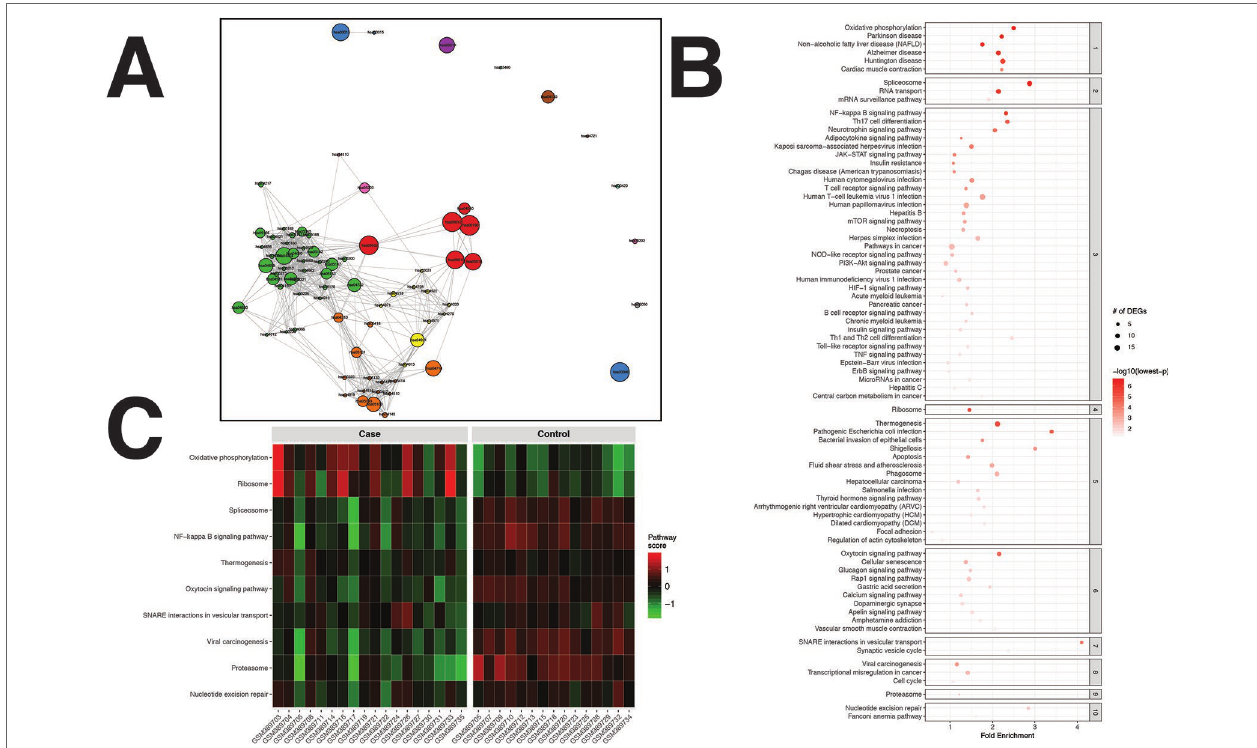
FIGURE 2 | pathfindR enrichment and clustering results on the rheumatoid arthritis (RA) dataset (lowest p ≤ 0.05). (A) Clustering graph, each color displaying the clusters obtained for RA. Each node is an enriched pathway. Size of a node corresponds to its −log(lowest_p). The thickness of the edges between nodes corresponds to the kappa statistic between the two terms. (B) Bubble chart of enrichment results grouped by clusters (labeled on the right-hand side of each panel). The x axis corresponds to fold enrichment values, while the y axis indicates the enriched pathways. The size of the bubble indicates the number of differentially expressed genes (DEGs) in the given pathway. Color indicates the −log10(lowest-p) value; the more it shifts to red, the more significantly the pathway is enriched. (C) Heat map of pathway scores per subject. The x axis indicates subjects, whereas the y axis indicates representative pathways. Color scale for the pathway score is provided in the right-hand